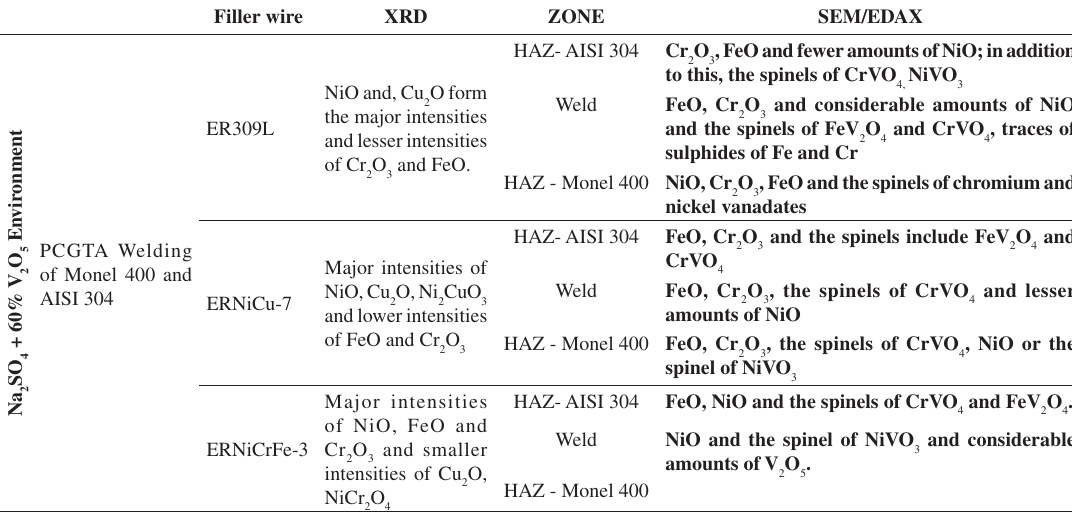
SD + 60% V D environment at 600 °C. 2 4 2 5